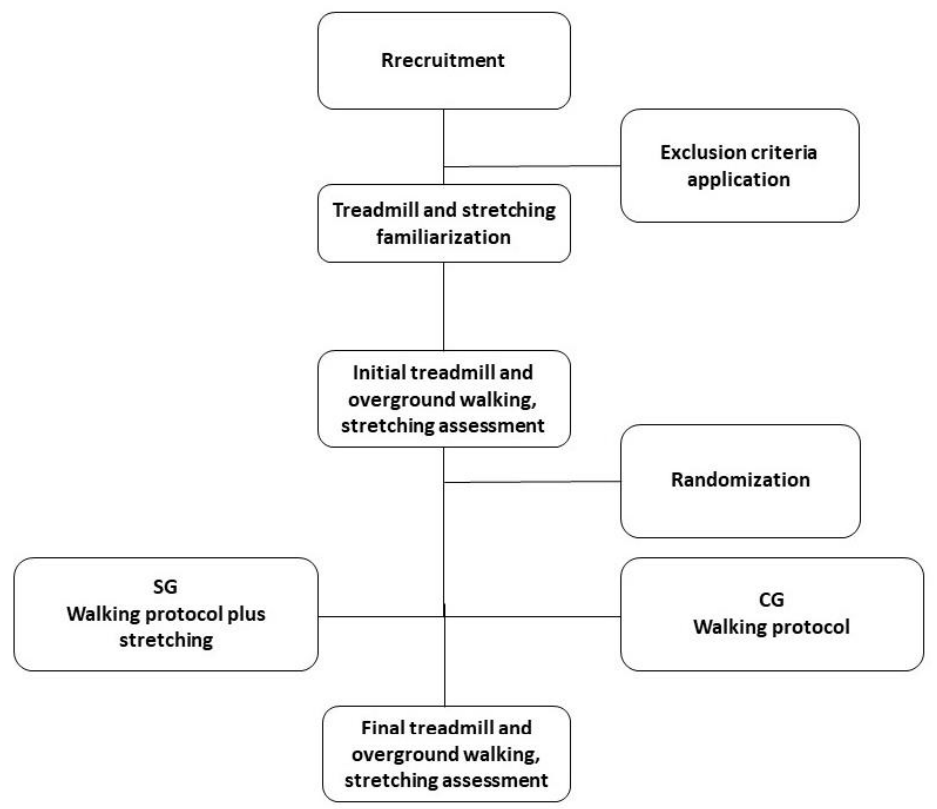
Figure 1. Study procedures flow chart. SG: stretching group; CG: conditioning group.